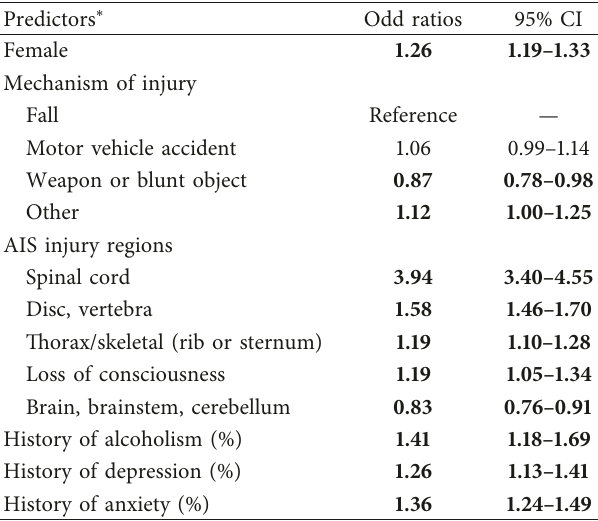
Table 4: Results of the multivariate logistic regression analysis to predict the development of chronic pain in the derivation sample ( N �